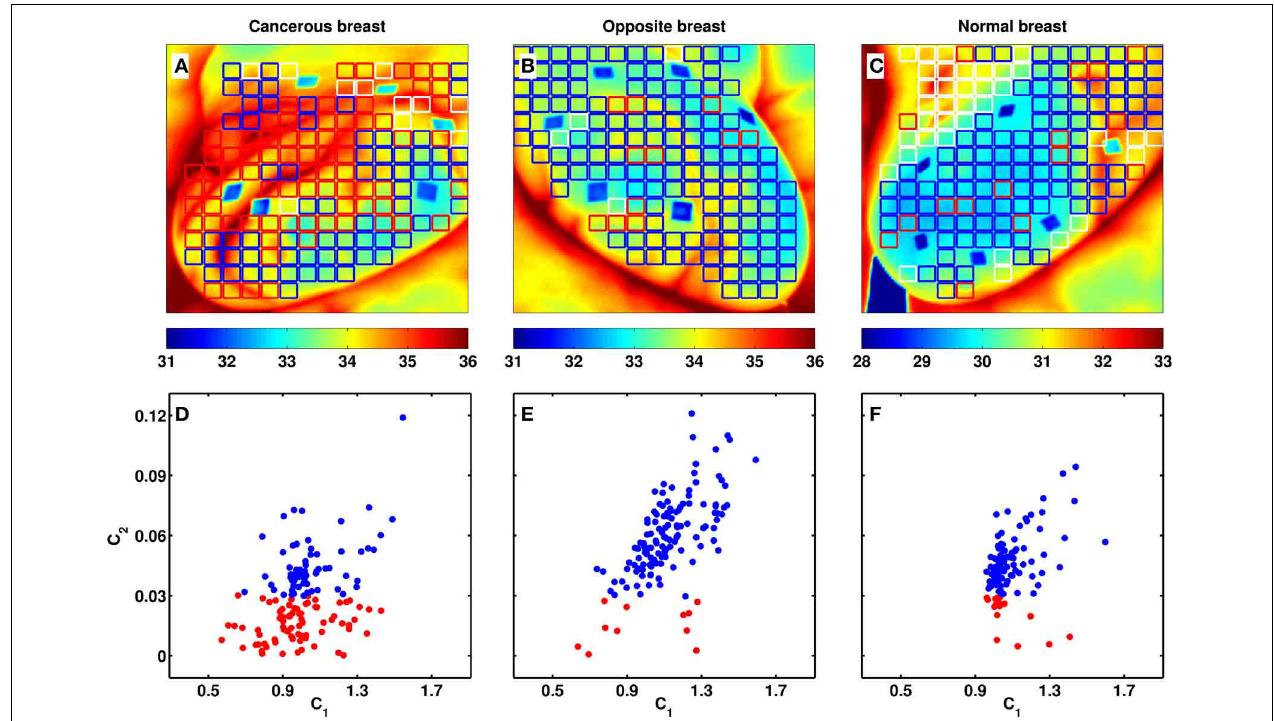
FIGURE 4 | Breast-wide multifractal analysis of skin temperature temporal fluctuations. As estimated from the τ ( q ) spectra computed with the WTMM method ( Figure 1E ), 8 × 8 pixel 2 squares covering the entire breast are colored coded (A–C) and represented as a dot in the ( c 1 , c 2 ) plane (D–F) . The colors have the following meaning: red: c 2 < 0 . 03, blue: